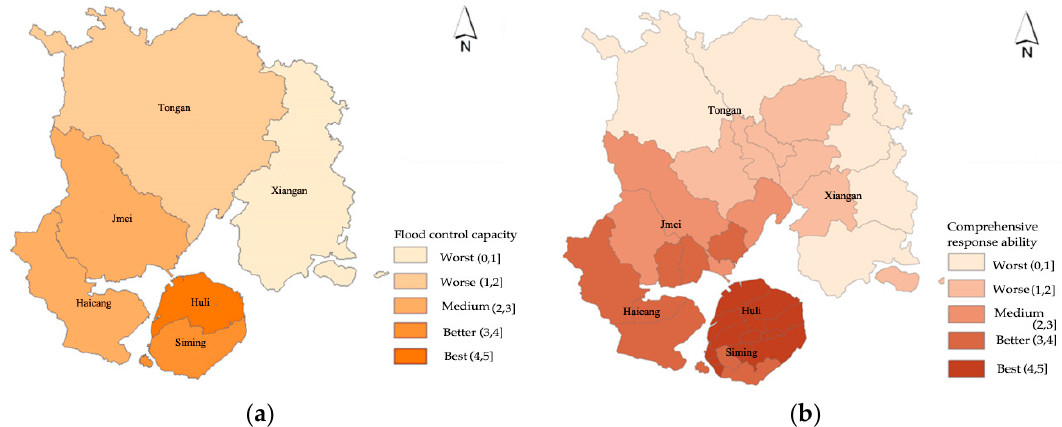
Figure 6. Analysis of the disaster prevention of Xiamen: ( a ) analysis of the flood control capacity; and ( b ) analysis of the comprehensive response ability.